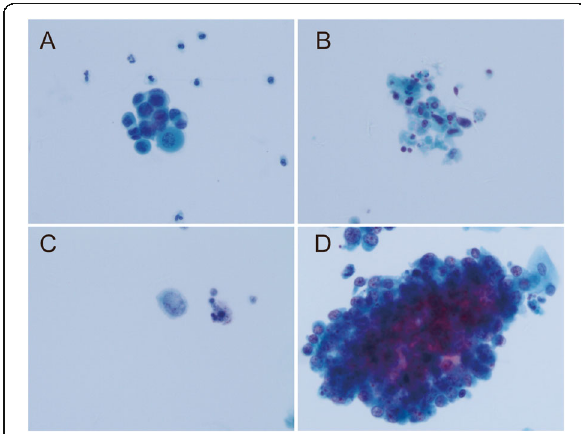
Fig. 1 Representative images of atypical and malignant cells. a Atypical cells. Some cells exhibit indistinct cytoplasmic borders and an increased nucleus-to-cytoplasm ratio; histological assessment of the patient revealed LGUC. b Atypical cells. The cells have hyperchromatic nuclei, irregular nuclear membrane, and a high nucleus-to-cytoplasm ratio; histological assessment of the patient revealed HGUC. c - d Malignant cells. A single cell and cell cluster, respectively; histological assessment of the patient revealed HGUC (Papanicolaou stain, original magnification 400×). LGUC, low-grade urothelial carcinoma; HGUC, high-grade urothelial